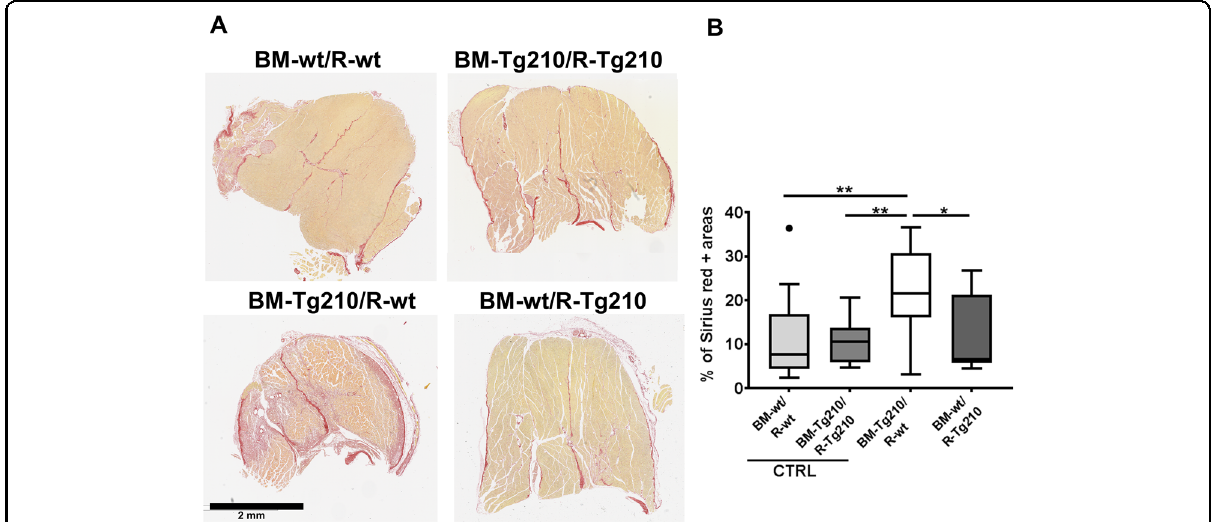
Fig. 3 BM-Tg210/R-wt ischemic muscles display tissue fi brosis after ischemia. A Representative images of Sirius red stained sections of ischemic gastrocnemius muscles of BM-wt/R-wt, BM-Tg210/R-Tg210, BM-Tg210/R-wt, and BM-wt/R-Tg210 mice. Collagen fi bers were stained in red. Calibration